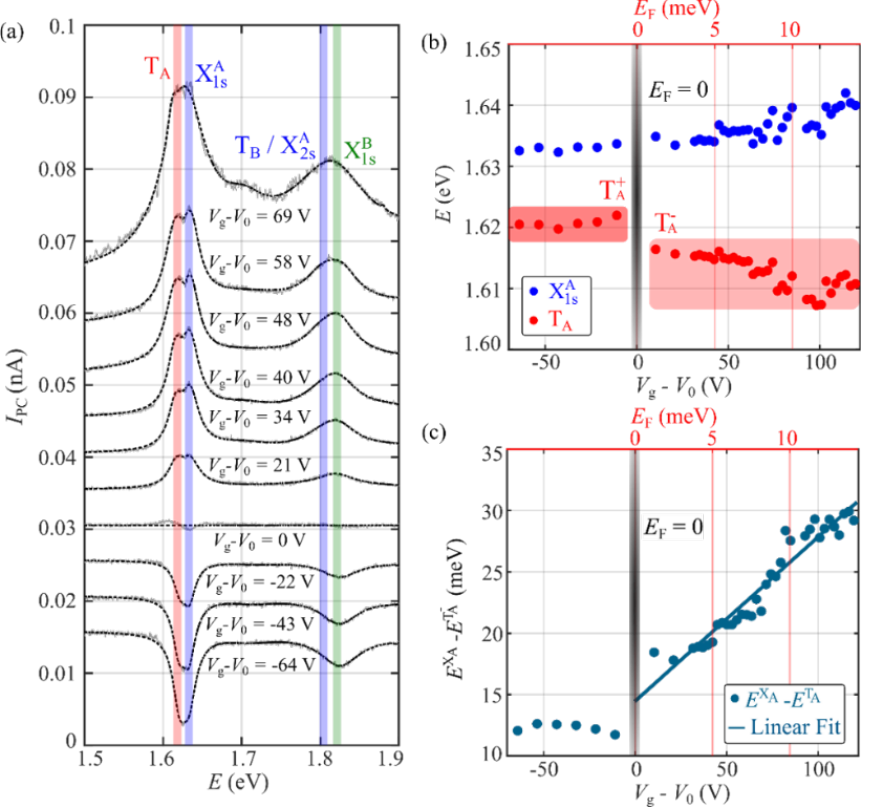
Figure 5. Gate dependence of the photocurrent spectra: ( a ) Individual photocurrent spectra (grey lines) acquired at different gate voltages, V g − V 0 , in a range between − 64 V and 69 V, fitted to a multipeak Lorentzian function (dashed black lines). For clarity, the spectra are vertically offset in steps of 0.005 nA. ( b ) Evolution with gate voltage of X A ( c ) Gate voltage dependence of the energy splitting between the X A